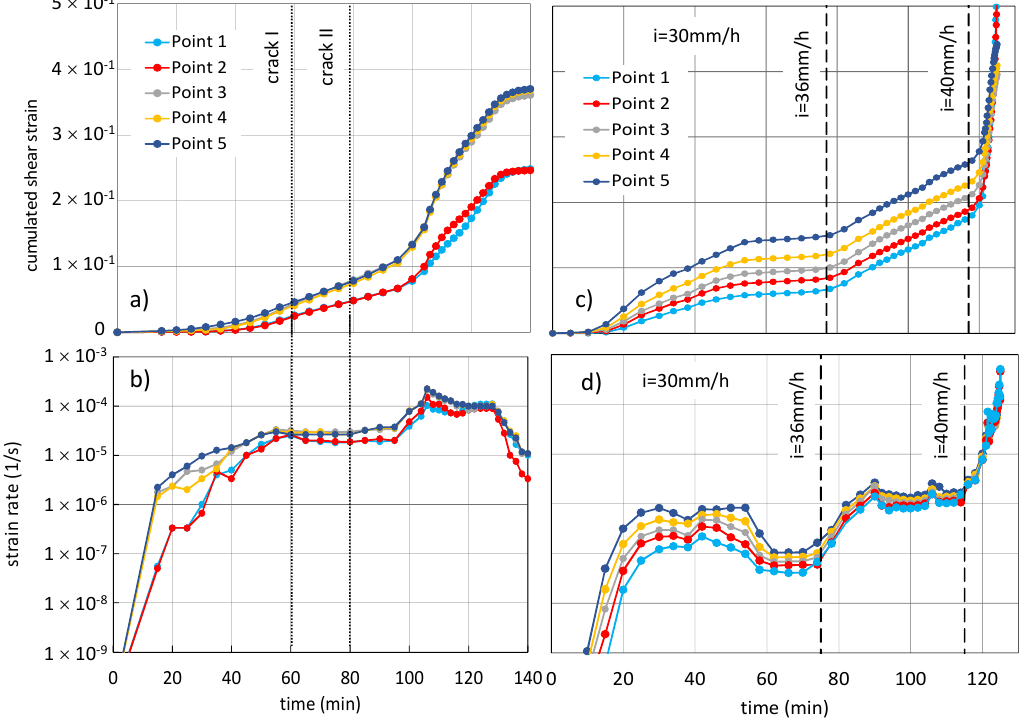
The ductile soil behavior, which attains a cumulated shear strain of 3.5 × 10 − 1 and a strain rate of roughly 10 − 4 s − 1 in the upper zone (RP2 experiment, Figure 13a,b).